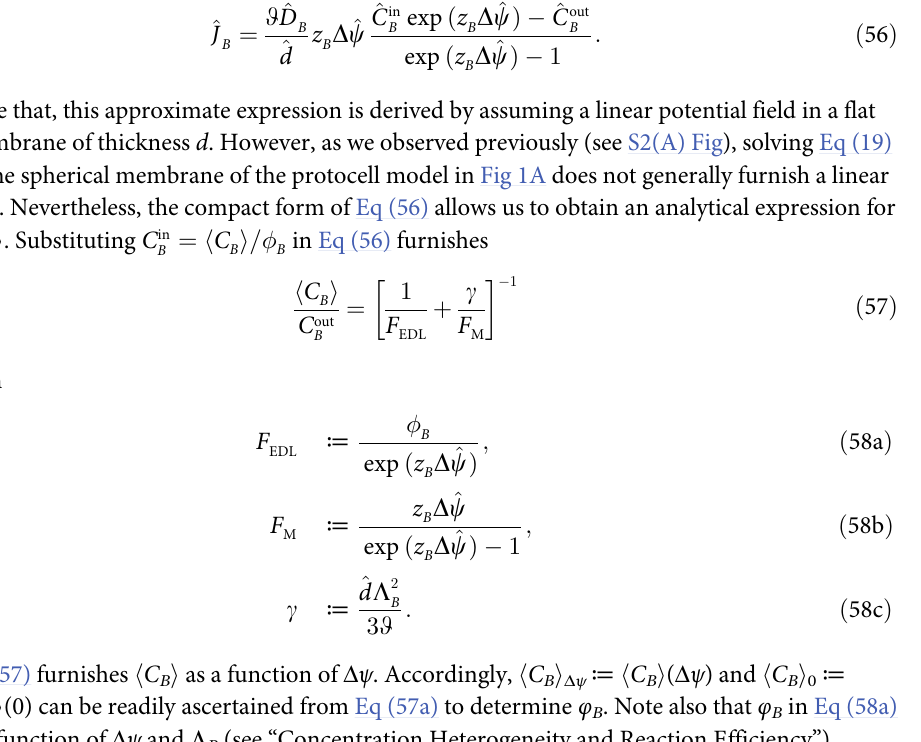
S2 Fig. Steady-state solutions of species mass-balance and Maxwell’s first equations at R = 0.2. (A) Electric potential, (B) volume-charge density, 10 − 7 m, σ = 0.01 C/m 2 , and σ r